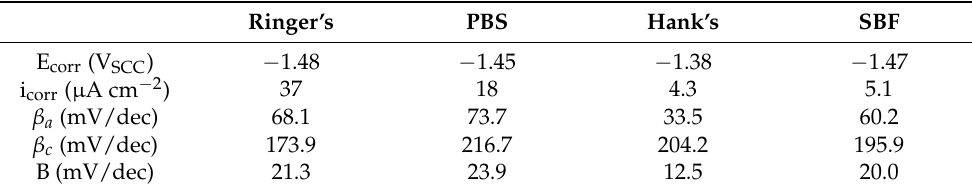
Table 5. Data from polarization curves of AZ31B Mg alloy in Ringer’s, PBS, Hank’s, and SBF solutions.